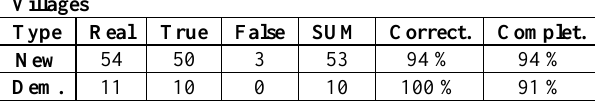
Table 5. Change detection results for villages The created method achieved very good final values for suburbs and excellent values for villages. The average completeness is 89.5 % and average correctness reaches almost 95 %.